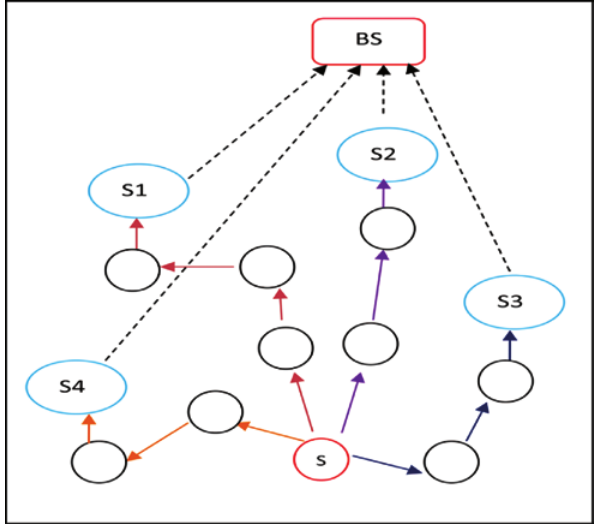
Figure 1: Multiple Sink Placement